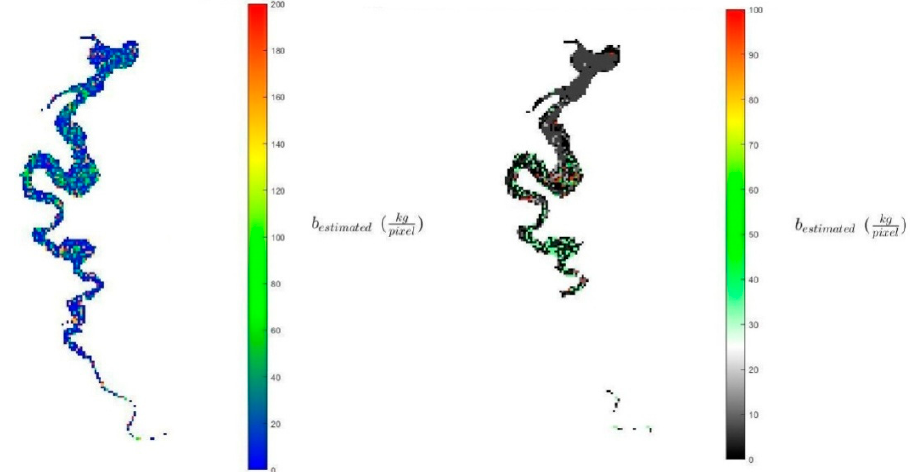
Figure 7. Predicted fish biomass distribution map along the reservoir for Landsat 5 validation image (left—29 July 2008) and Landsat 8 validation image (right—20 August 2016).